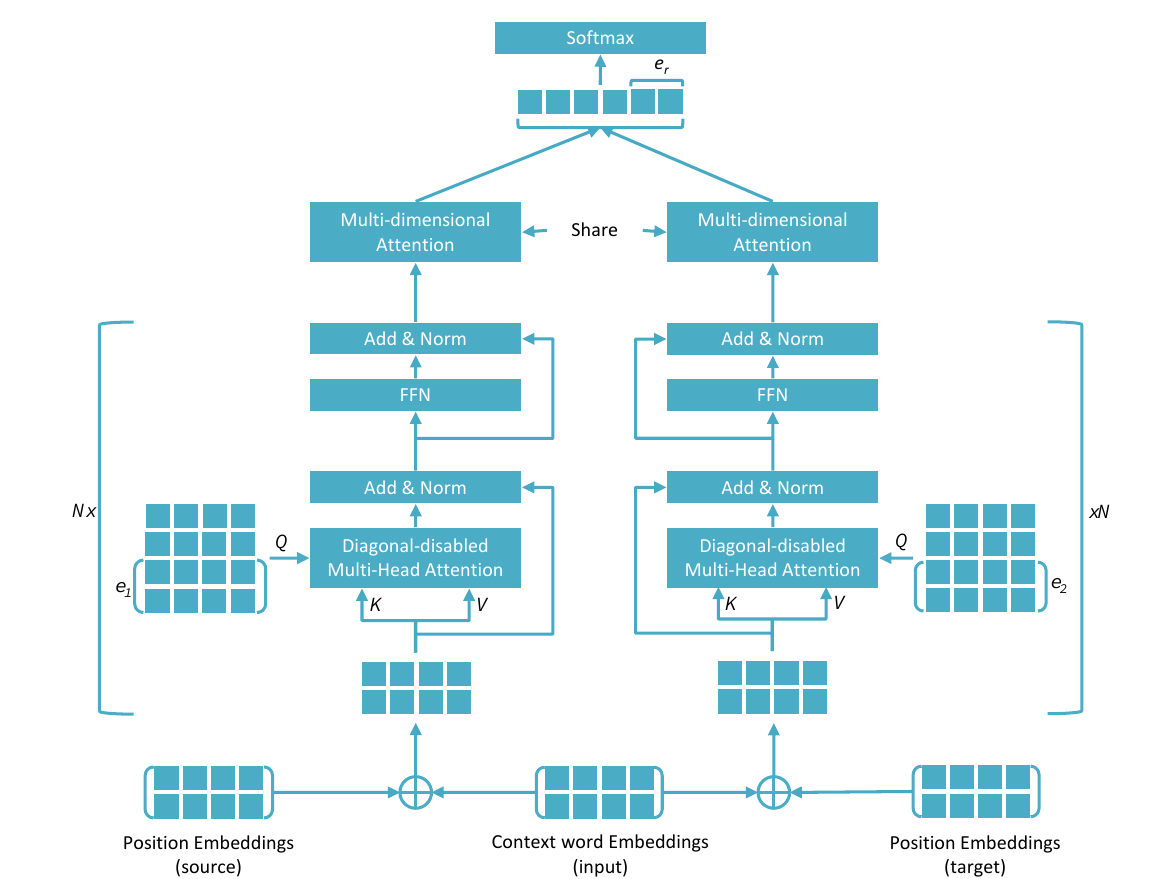
Figure 4. Architecture of the Knowledge-aware Attention Network (KAN). The symbol N × next to the marked blocks represents N copies of the respective blocks, where N can be defined by the modeler. The architecture has two parallel input channels, taking information on the source and target entity as the input along with the relevant text. External knowledge is integrated into the model in the form of entity-specific representations e 1 and e 2 and a representation of their known relationship e r